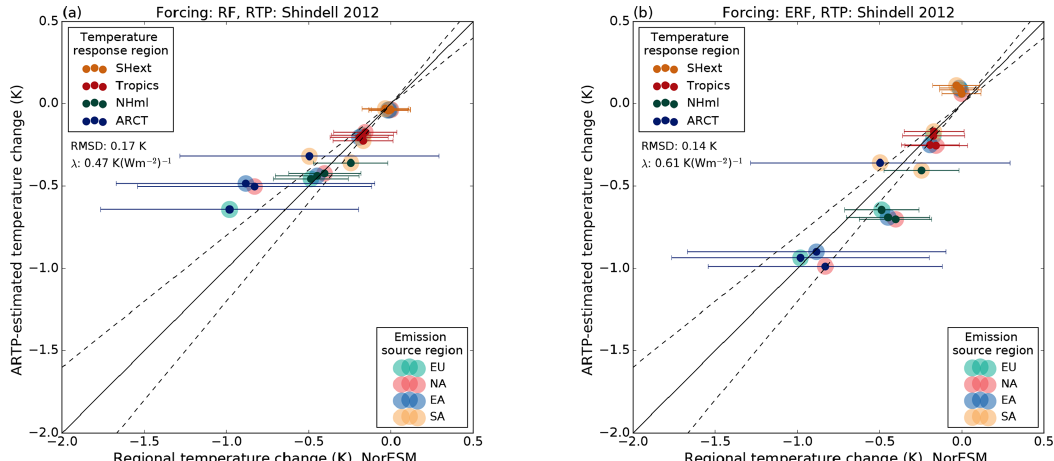
Figure 12. As Fig. 11 but with the RTP coefficients of Shindell (2012), Eq. (2) with the climate sensitivity derived from the current experi-